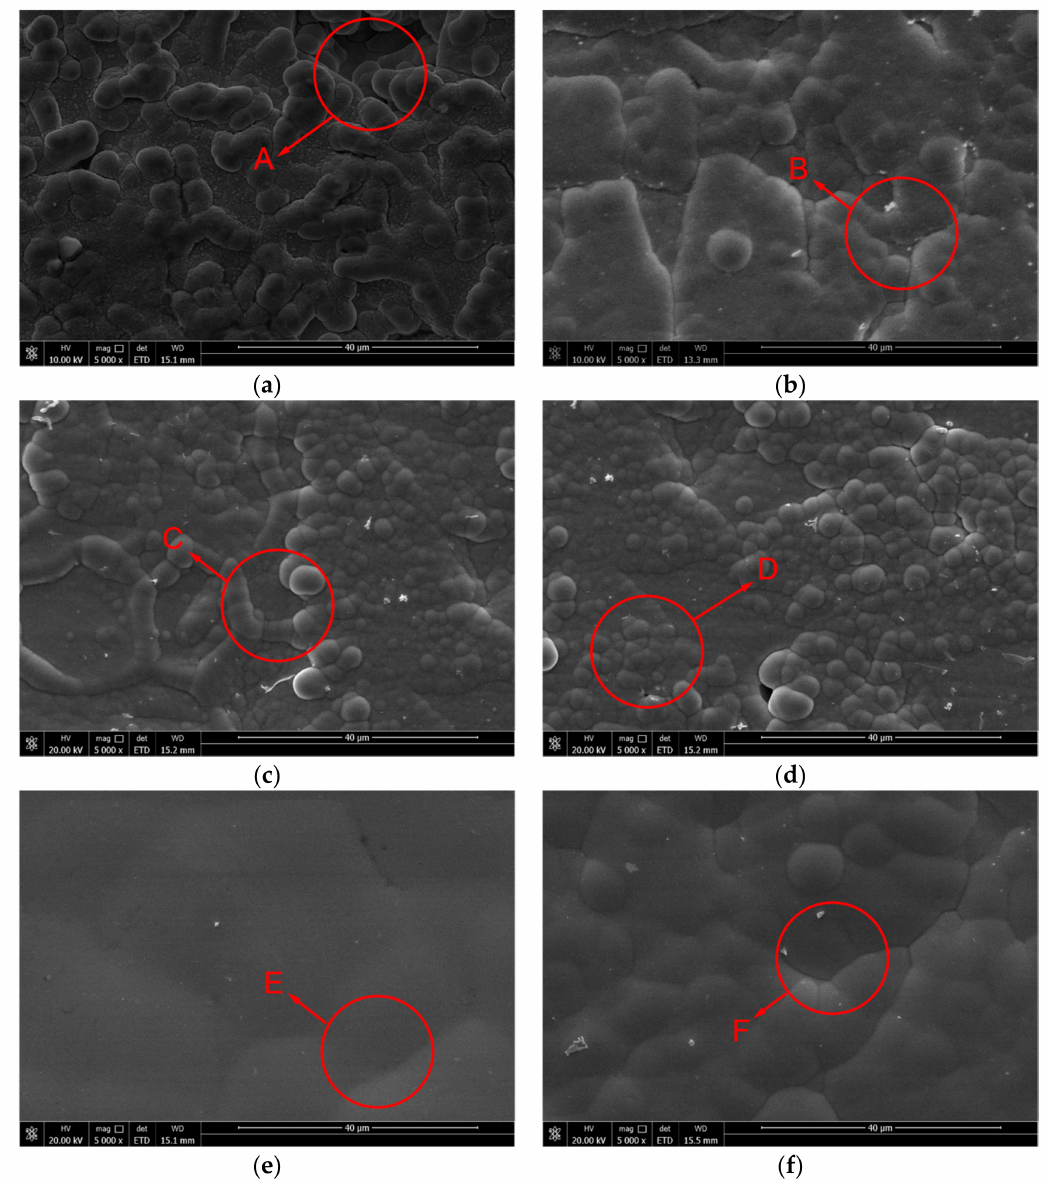
Figure 4. Surface micro-morphology of the coating. ( a ) 30 A · dm − 2 (J) ( b ) 20 A · dm − 2 ( c ) 30 A · dm − 2 ( d ) 40 A · dm − 2 ( e ) 50 A · dm − 2 ( f ) 60 A · dm − 2